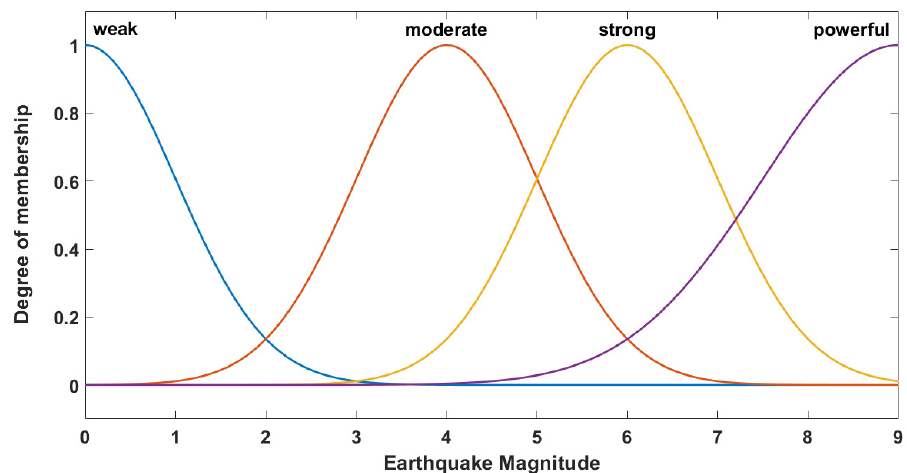
Figure 5. Membership functions of the output data.